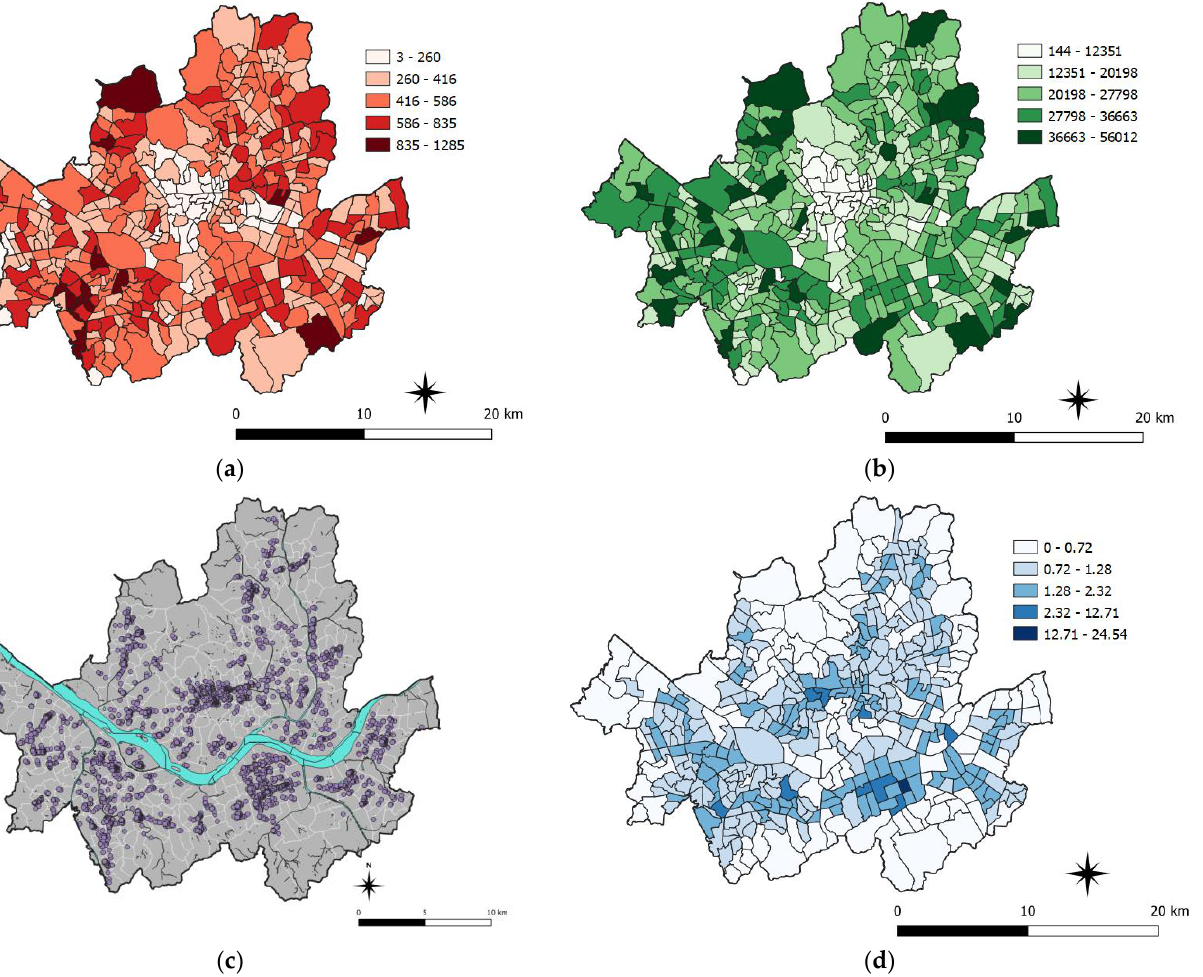
Figure 4. Data visualization of important variables. ( a ) distribution of COVID-19 confirmed patients; ( b ) distribution of floating population; ( c ) location of entertainment facilities; ( d ) density of five facilities Table 3. Frequency analysis results.